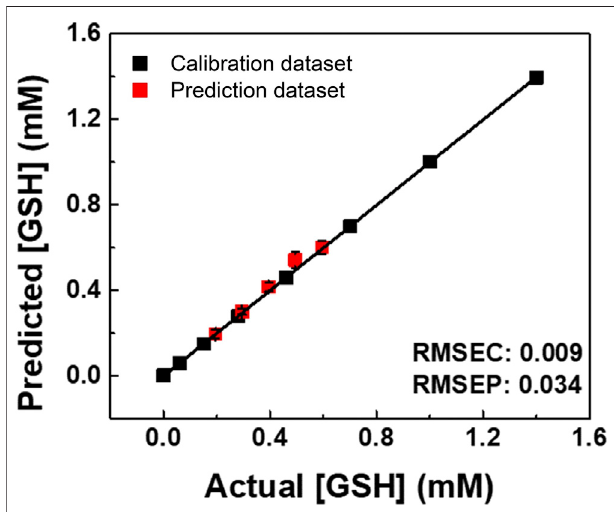
FIGURE5| SVMregressionforrealsampleanalysisofGSHinajuice(Ito En tomatojuice). The RMSEC and RMSEP values (shown as insets) represent the accuracy of the constructed model and the